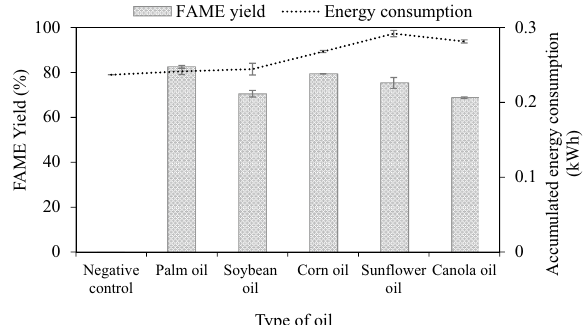
Figure 7. Effect of various types of vegetable oils on steady-state FAME yield (2000 mL, 50 mL/min, 1 wt% NaOH, 62–63